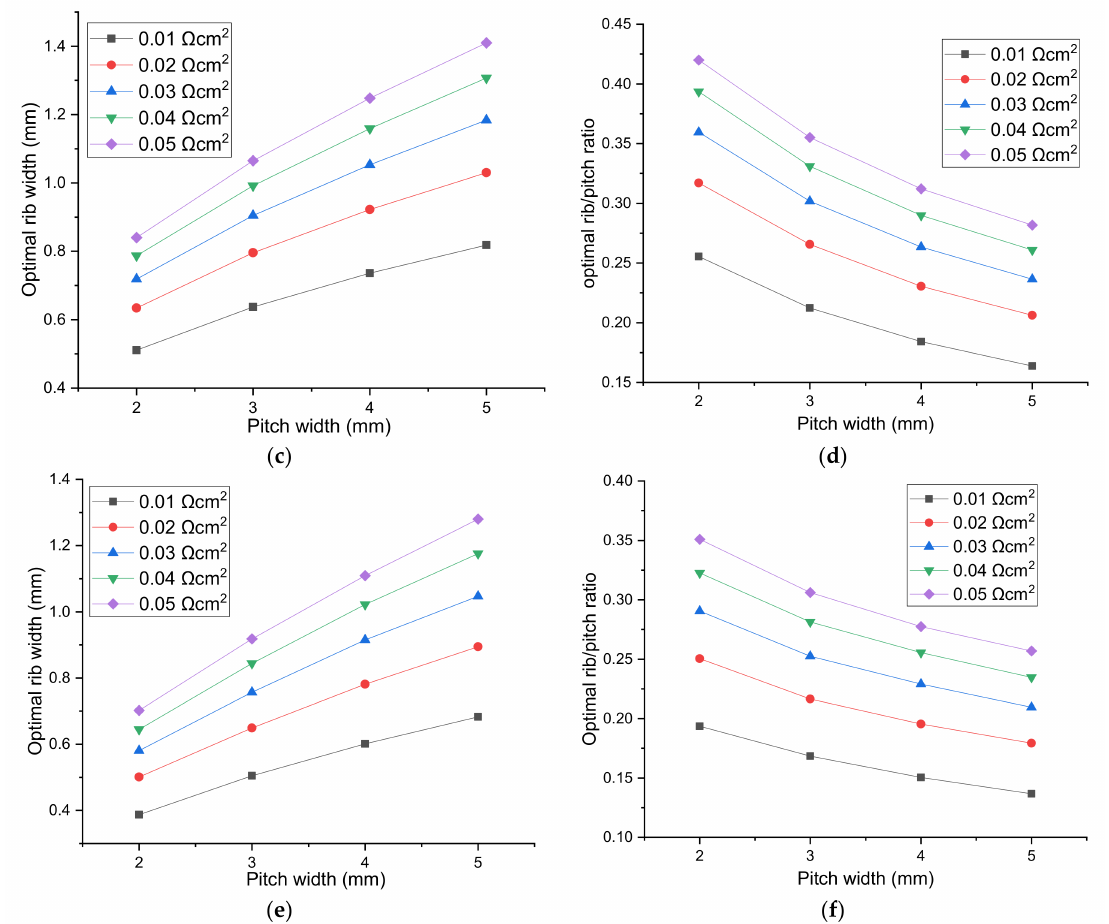
Figure 6. The optimal H 2 electrode rib width and rib / pitch ratio for di ff erent pitch width for the cell voltage of ( a , b ): 1.2 V; ( c , d ): 1.4 V; ( e , f ): 1.6 V.